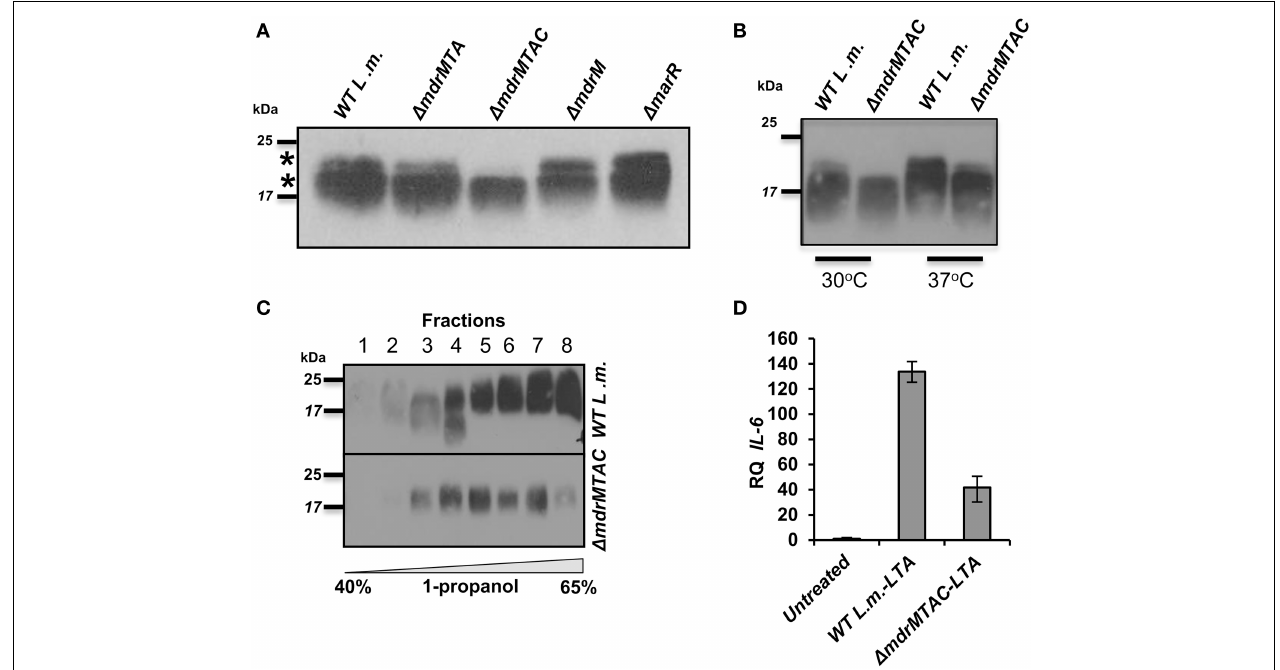
extracted by water/butanol extraction method and separated on HPLC using analytical RP-C8 column. Gradient represents percentage of ammonium acetate-propanol (15–65%). LTA was obtained in the range of 40–65% 1-propanol. The data is representative of three biological repeats. (D) RT-qPCR analysis of IL-6 transcription levels in BMD macrophage cells exposed for 6h to LTA derived from WT L. monocytogenes